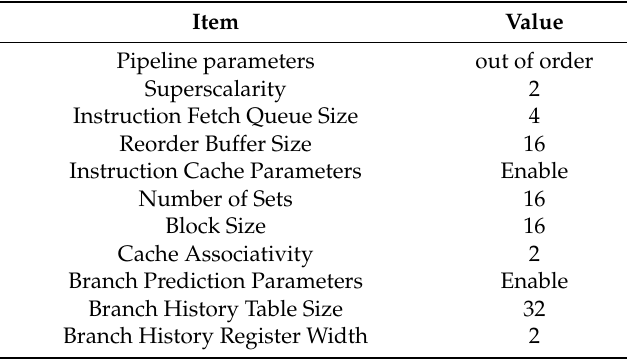
Table 5. The configuration of the complex processor.